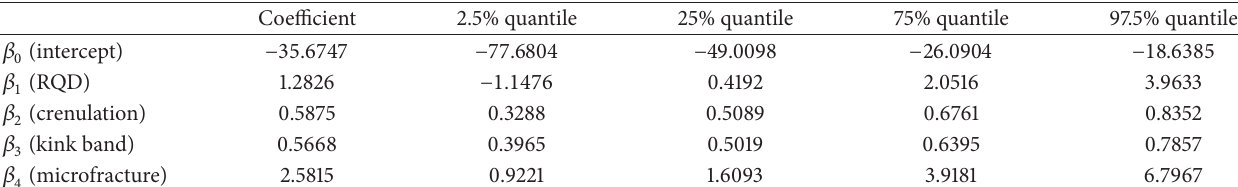
Table 2: Estimated coefficients and 2.5%, 25%, 75%, and 97.5% quantiles for the GLM.